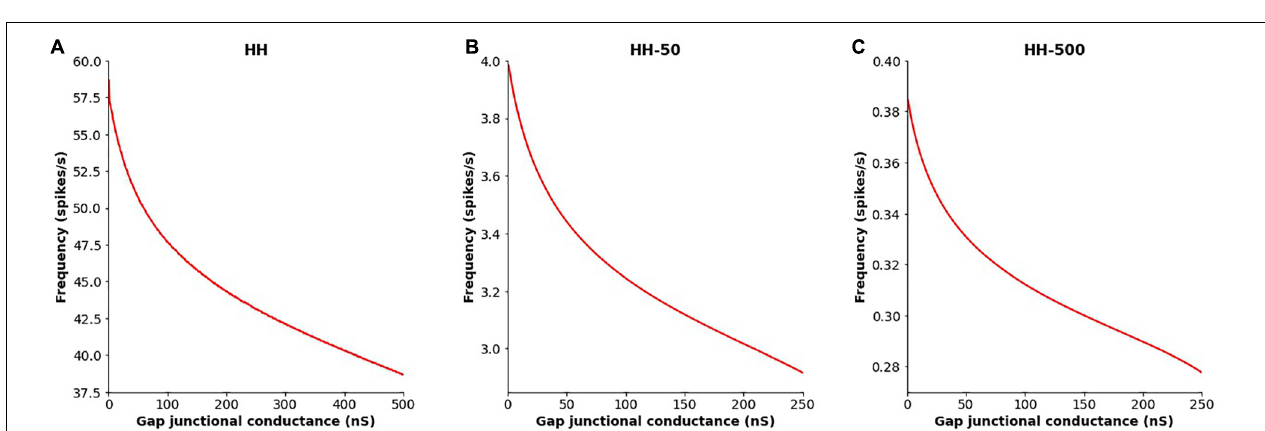
FIGURE 3 | Action potential oscillations observed at the central cell in the 1-D chain of cells, when employing a constant gap junctional mechanism under various levels of gap junctional coupling: (A) 5 nS, (B) 50 nS, and (C) 500 nS. It can be clearly seen that an increase in coupling strength between cells, leads to a reduction in the frequency of oscillations.